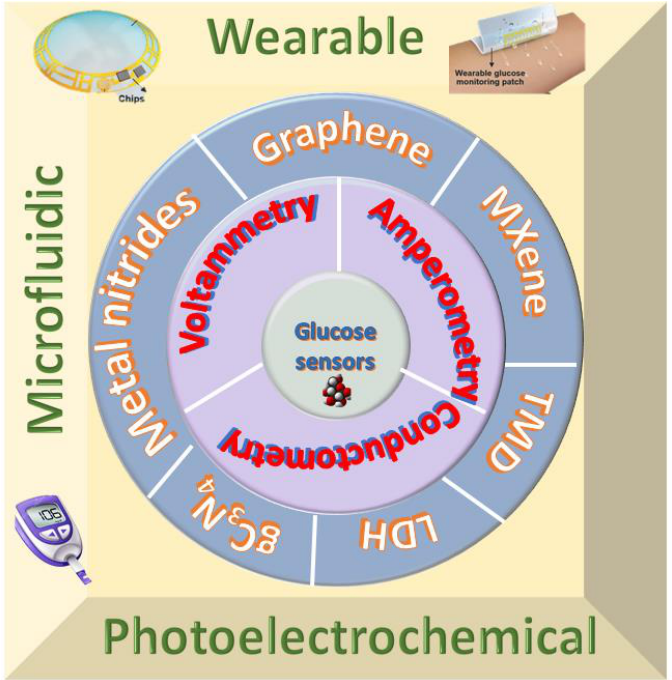
Figure 1. Summary of recent advancement of two-dimensional materials for electrochemical glucose sensors.